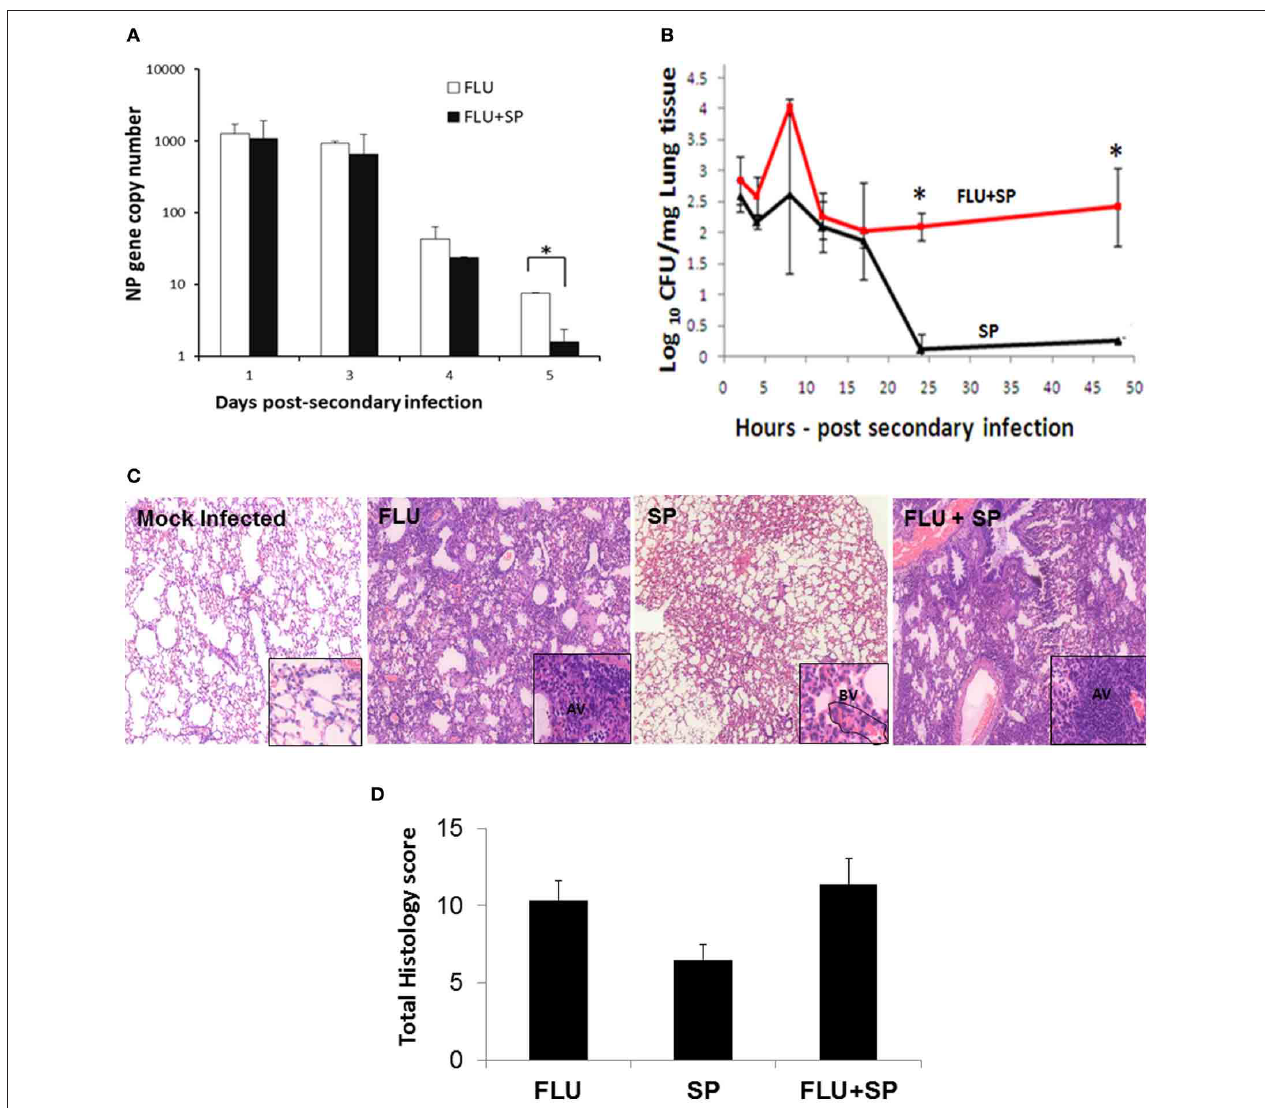
FIGURE 1 | Effects of influenza and/or S. pneumoniae infections on their replication and on lung pathology. (A,B) C57BL/6 mice were infected with sub-lethal doses (30 PFU) of influenza virus (FLU) or mock-infected with PBS (control). Seven days after influenza infection, mice were challenged with sub-lethal doses of S. pneumoniae 19F for viral and bacterial co-infection experiments (FLU + SP). For bacterial infection alone (SP), mice were infected with sub-lethal doses of S. pneumoniae 19F. N = 3 per animal group. ∗ Denotes P < 0 . 05. (A) Expression of the viral nucleoprotein gene was measured by real-time RT-PCR analysis until 5 days post-secondary infection. (B) Growth of S. pneumoniae in the lung homogenates of mice with dual infection and bacterial infection only was determined by the number of CFU until 48h post-secondary infection. (C,D) C57BL/6 mice were infected with lethal doses of influenza virus (250 PFU) or mock-infected with PBS (control).